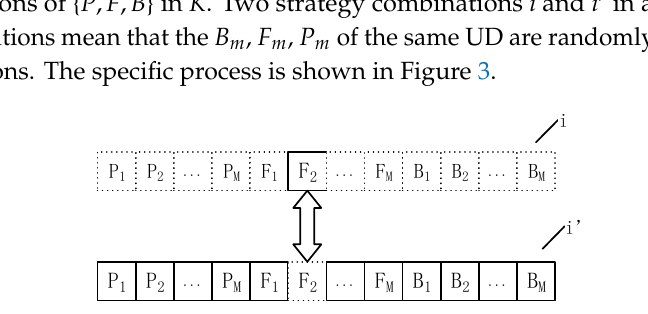
Figure 3. Crossover operation.